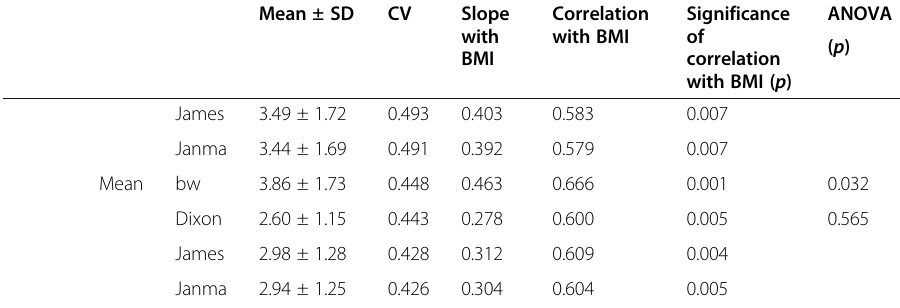
Table 4 Fitting results and dependent analysis of SUV vs BMI for the PSMA study ( n = 28) (Continued) Mean ± SD CV